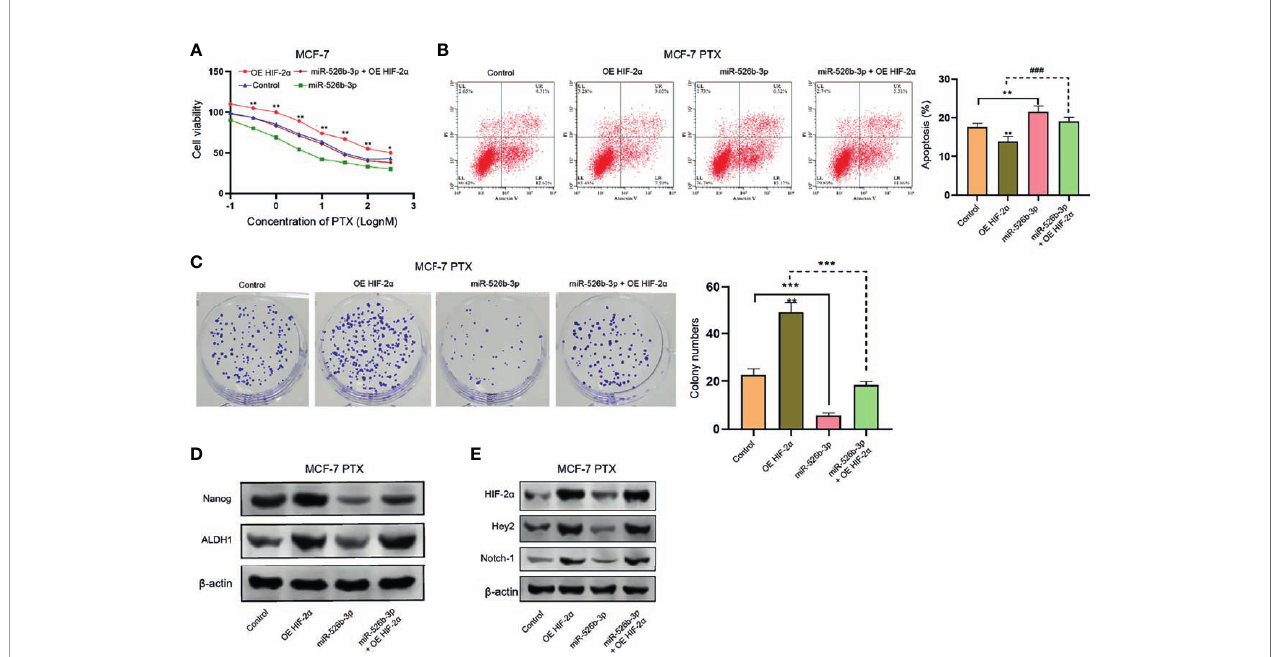
FIGURE 7 | MiR-526b-3p attenuates PTX resistance of breast cancer cells by targeting HIF-2 a . (A) MCF-7 cells were treated with different concentrations of PTX and were cotreated with miR-526b-3p mimic or HIF-2 a overexpression plasmid. Viability of MCF-7 cells was detected by MTT analysis. (B – E) MCF-7 cells were treated with PTX (3 nM) and cotreated with miR-526b-3p mimic or HIF-2 a overexpression plasmid. (B) Apoptosis of MCF-7 cells was determined by fl ow cytometry analysis. (C) Proliferation of MCF-7 cells was detected by colony formation assays. (D) The protein expression of ALDH1 and Nanog was tested by Western blot. (E) The protein expression of HIF-2 a , Hey2, and Notch-1 was assessed by Western blot. Data are mean ± SD: * p < 0.05, ** p < 0.01, *** p < 0.001; ### p <